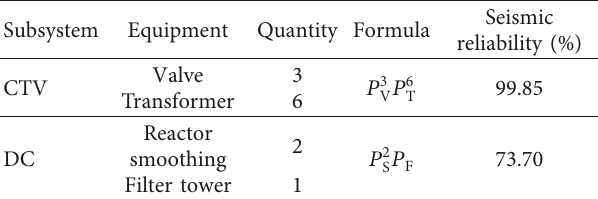
Table 3: Seismic reliability of a monopolar subsystem of the UHVDC transmission system.